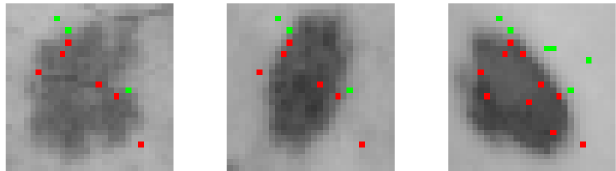
Figure 15. Samples belonging to the “malignant” class, sharing a rule. The first and the third case activate a single rule, while the second is covered by two